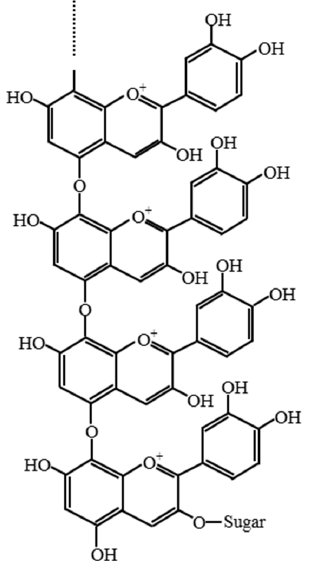
Figure 10. The structure of oligomeric anthocyanin.